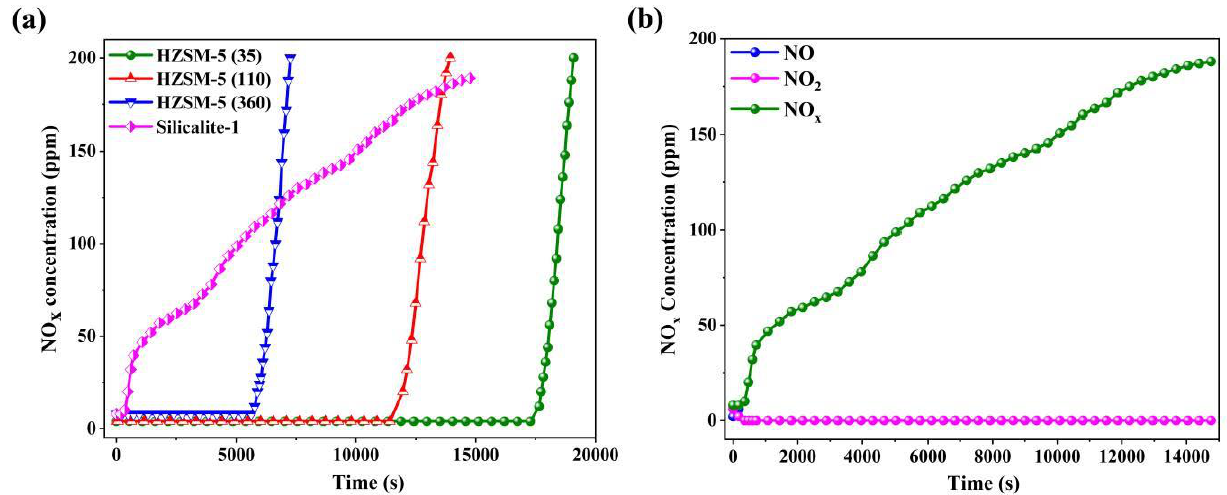
Figure 6. ( a ) Breakthrough curves of NO x on all samples under dry conditions. ( b ) Breakthrough curves of NO, NO 2 , and NO x on Silicalite-1.